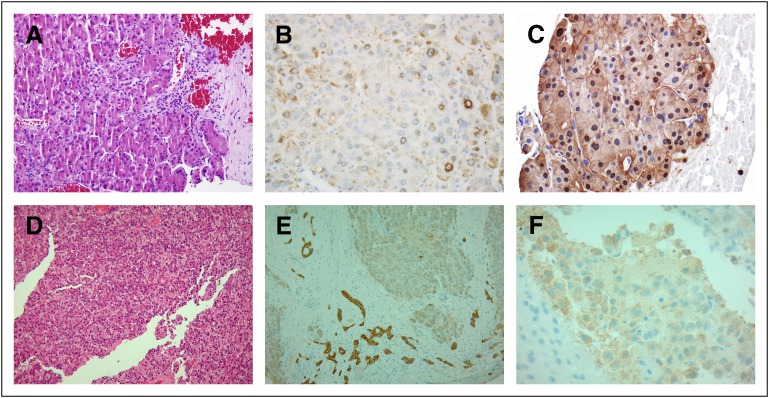
(A) Mandible biopsy (hematoxylin and eosin [HE] ×20). The biopsy was
composed entirely of large polygonal oncocytic cells arranged in trabeculae
and clusters. (B) Left adrenal core biopsy (Hep-Par-1 immunohistochemical
stain). (C) Left adrenal core biopsy (arginase-1 [Arg-1] immunohistochemical
stain). The tumor was positive for Hep-Par-1 and Arg-1, consistent with
adrenal gland with hepatoid differentiation. (D) Liver biopsy (HE).
Histologic sections show loss of tissue architecture, with hepatocytes
arranged in trabeculae or acini. (E) Liver biopsy (cytokeratin AE1/AE3).
Diffusely and weakly positive immunostain. (F) Liver biopsy. (Hep-Par-1
immunohistochemical stain). Granular cytoplasmic staining pattern.